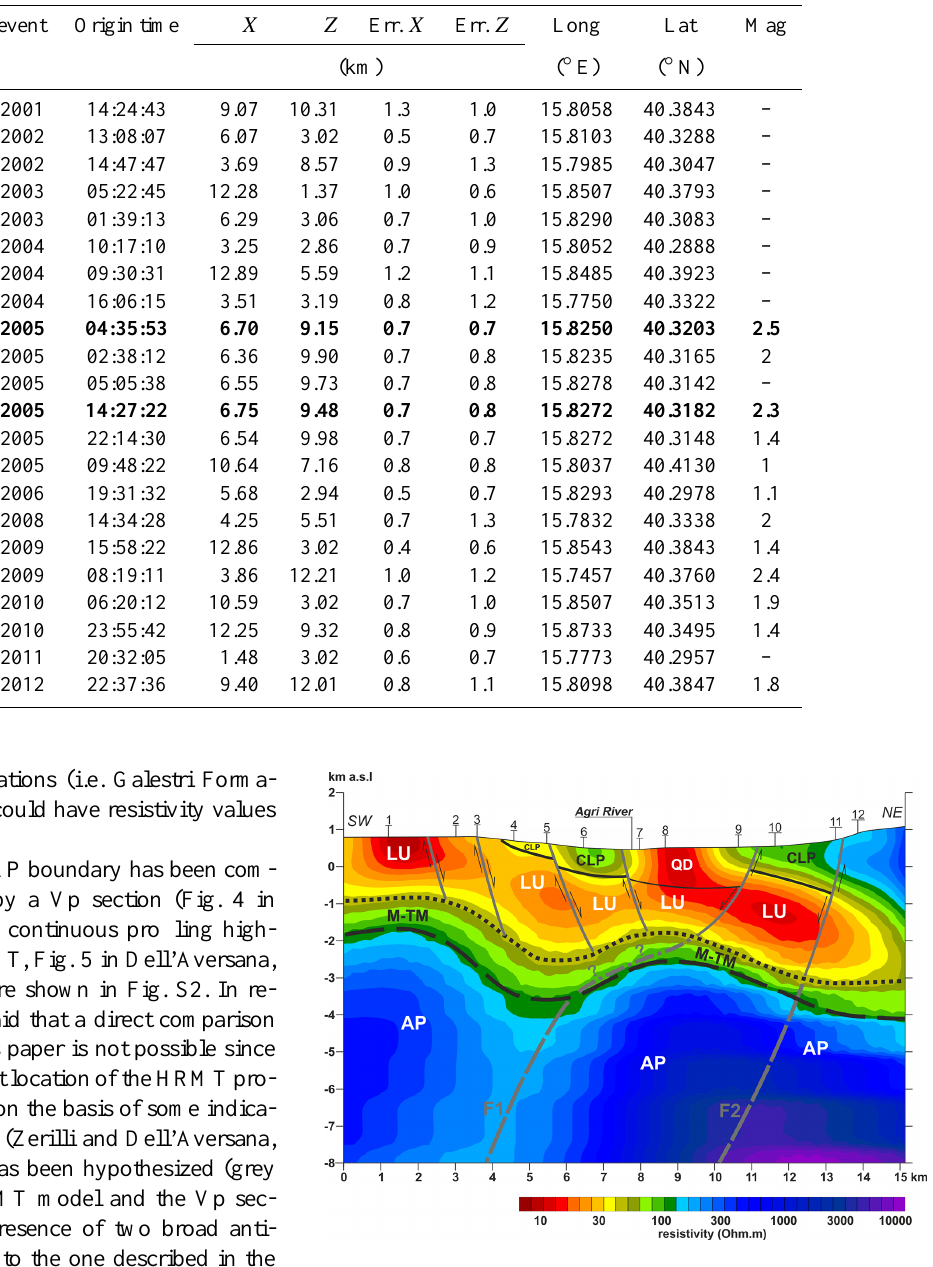
Figure 6. Schematic interpretation of the MT model. QD is Quater- nary deposits; CLP is Campania Lucania Platform; LU is Lagone- gro units; M-TM is mélange and terrigenous marine deposits; AP is Apulia Carbonate